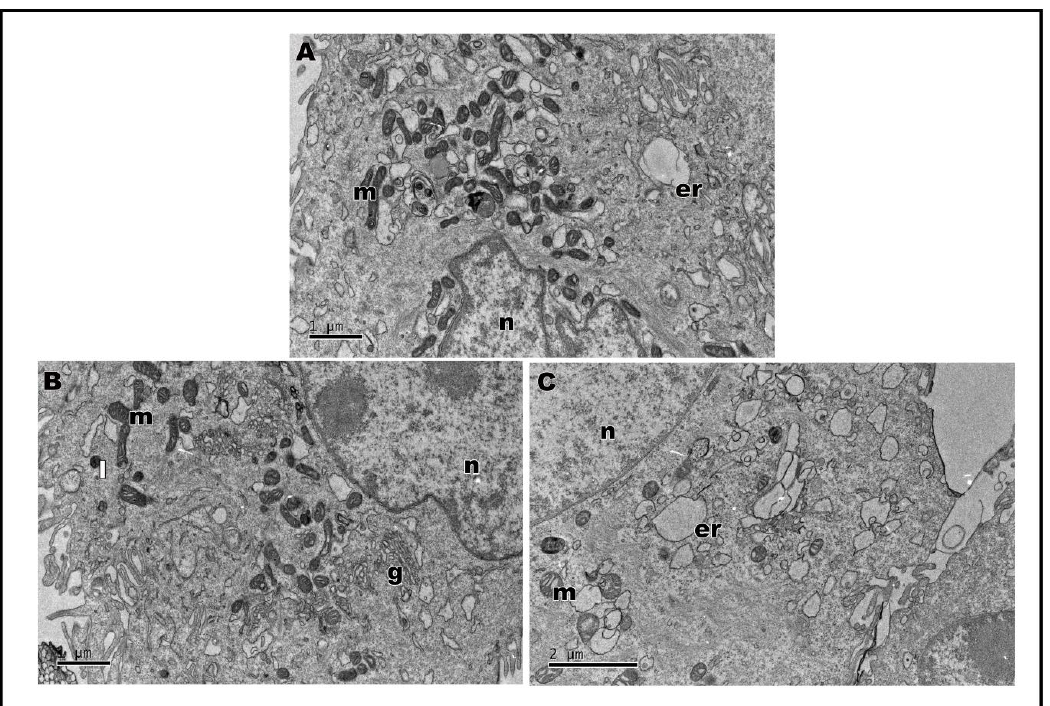
Figure 6. Transmission electron microscopy of HaCaT cells after 24 h of treatment with lipopolysac- charides (LPS) at 1 µ g/mL ( A ). Cell treatment with 5 µ g/mL of nanoLPG ( B ) or LPG ( C ) in the presence of lipopolysaccharides (LPS) at 1 µ g/mL. (m) mitochondria, (n) nucleus), (g) Golgi complex, (er) endoplasmic reticulum, and (l) lysosome .